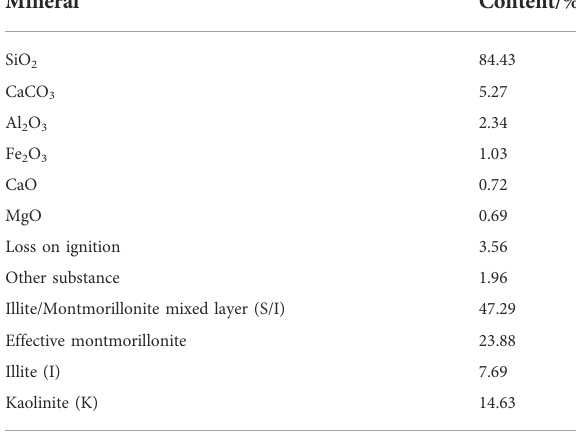
TABLE 1 Main chemical and clay mineral compositions of